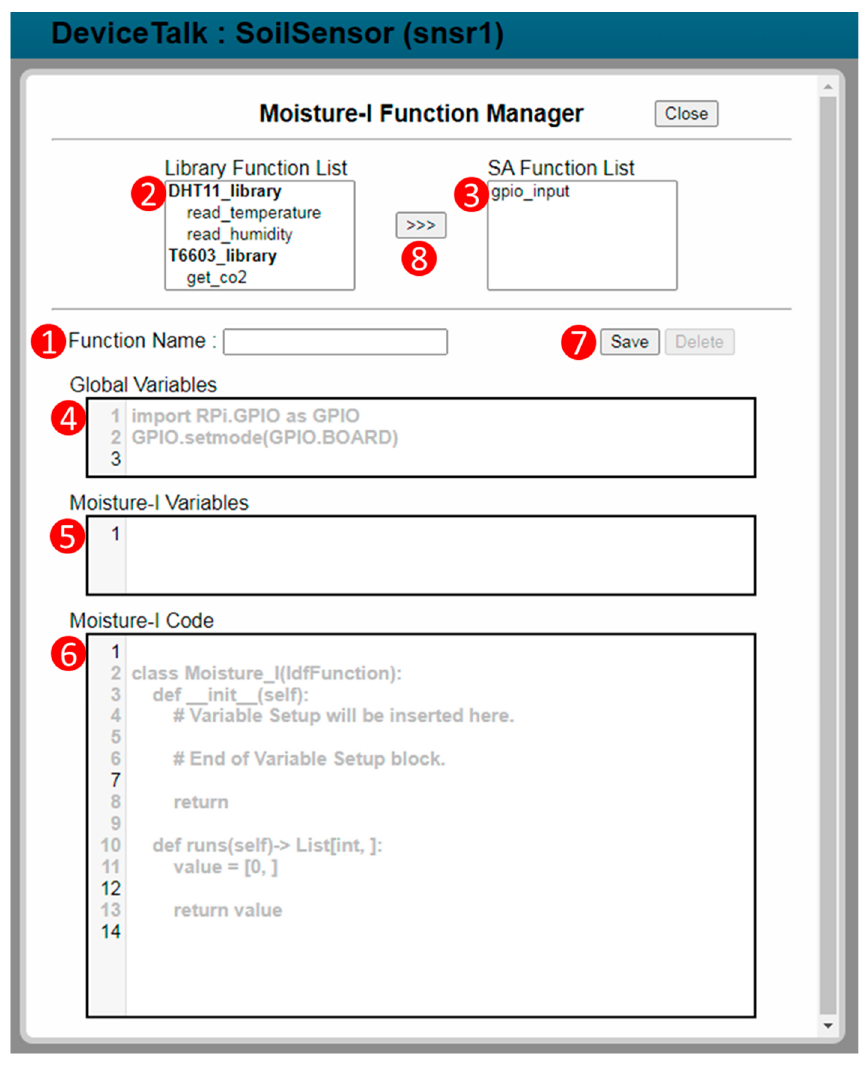
Figure A1. SA Function